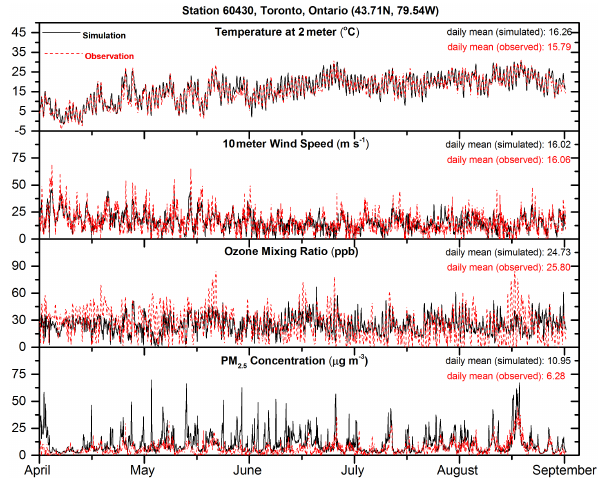
Figure 2. Simulated and observed time series of hourly tempera- ture at 2m above the surface, wind speed at 10m, hourly surface ozone and PM 2 . 5 concentrations from April to August 2009 at sta- tion 60430 located in Toronto.